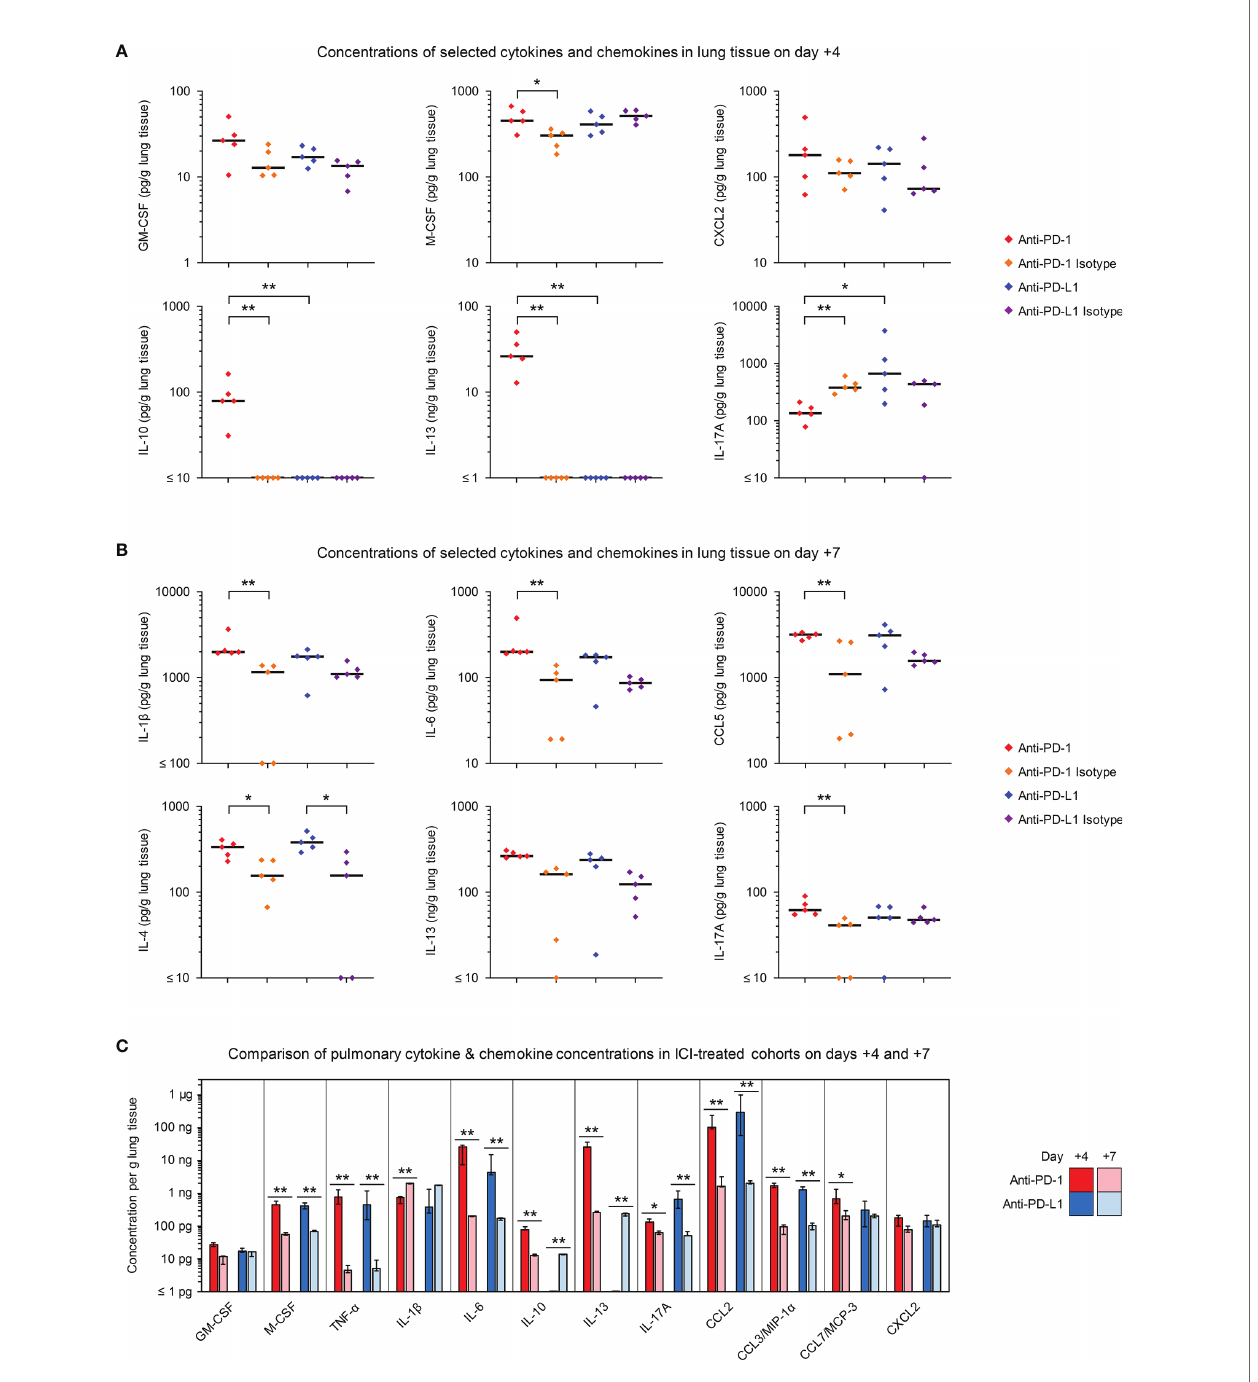
FIGURE 2 | Blockade of PD-1/PD-L1 signaling enhances proin fl ammatory cytokine release in infected lung tissue. (A, B) Cytokine and chemokine concentrations in lung tissue homogenates from R. arrhizus -infected mice receiving ICIs or isotype antibodies were measured on day +4 (A) and day +7 (B) using a 19-plex Luminex assay. Individual and median concentrations of selected cytokines are displayed. Raw data are shown in Figure S1 (day +4) and Figure S2 (day +7). The two-sided Mann-Whitney U test with Benjamini-Hochberg adjustment for a false discovery rate of 0.2 was used for signi fi cance testing (comparisons between ICI-treated mice and isotype controls as well as between the two ICI-treated cohorts). (C) Comparison of median day-4 and day-7 lung concentrations of selected cytokines and chemokines in ICI-treated mice. Error bars represent inter-quartile ranges. The two-sided Mann-Whitney U test with Benjamini-Hochberg adjustment for a false discovery rate of 0.2 was used to compare the two sampling time points for each treatment arm. * p < 0.05, ** p < 0.01. C(X)CL, C(-X)-C motive chemokine receptor ligand; (G)M-CSF, (Granulocyte) Macrophage Colony-Stimulating Factor; IL, Interleukin; MCP, Monocyte Chemoattractant Protein; MIP, Macrophage In fl ammatory Protein; TNF, Tumor Necrosis